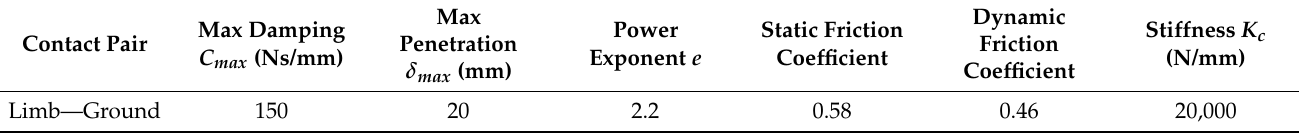
Table A4. Parameters involved in the ground–limb